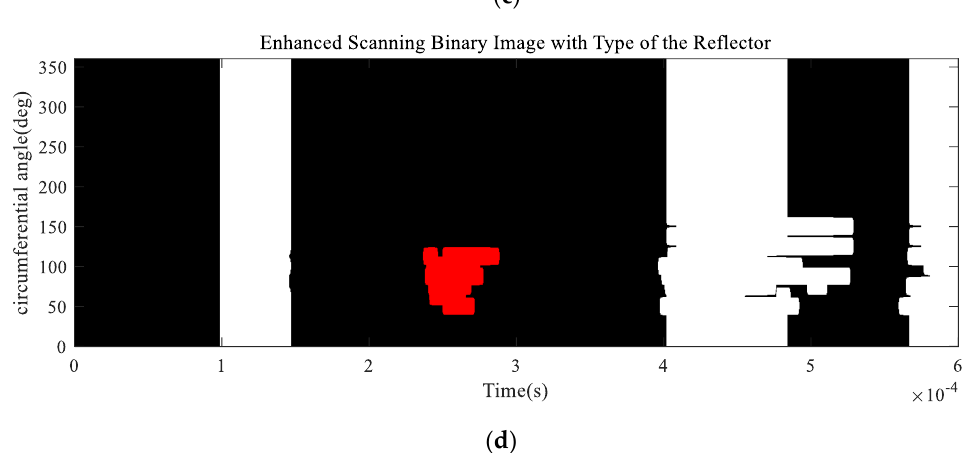
Figure 14. Analysis results based on the proposed method: ( a ) original 2D scanned image ( Up ), enhanced 2D scanned image ( Middle ) and smoothed 2D scanned image ( Down ); ( b ) enhanced 2D scanned binary image; ( c ) distance curves Ψ 1 ( Up ) and Ψ 2 ( Down ); ( d ) updated judgment results to the enhanced 2D scanned binary image with different colours.